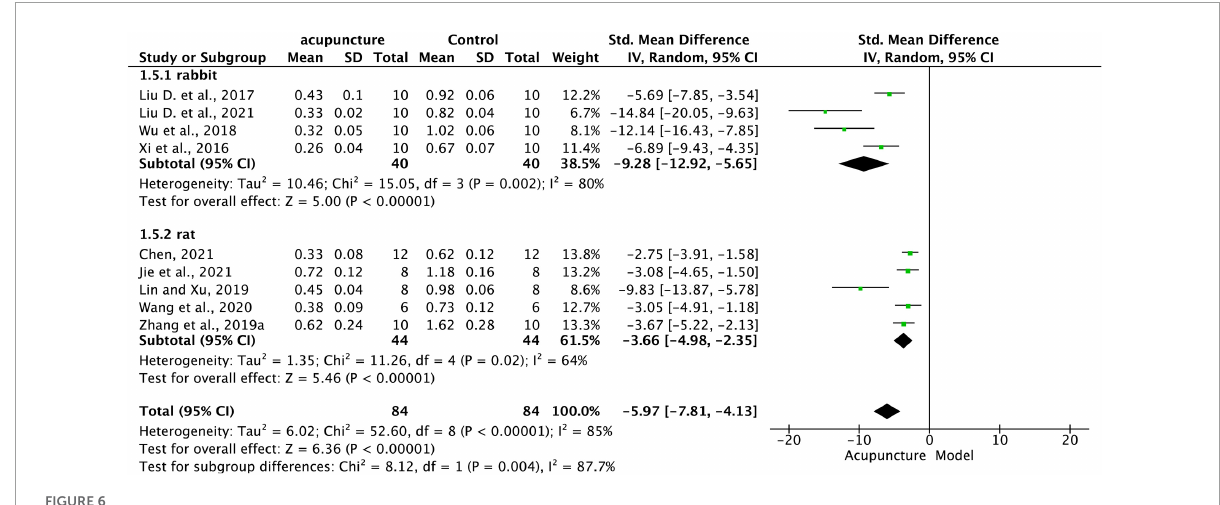
FIGURE6 Subgroup analysis of effects of acupuncture on MMP-13 in KOA cartilage in different animal models (rabbit and